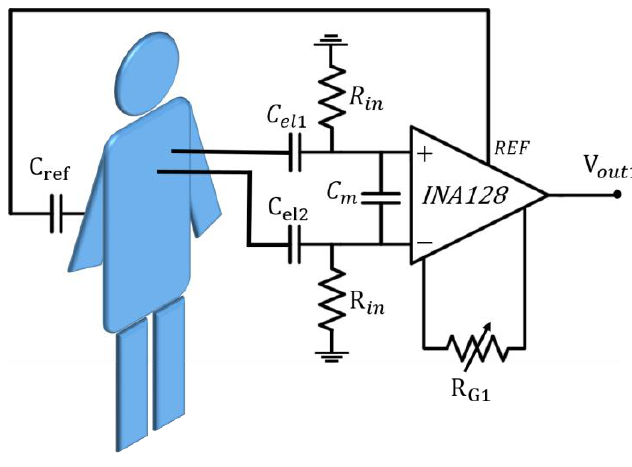
Figure 3. The front-end block.